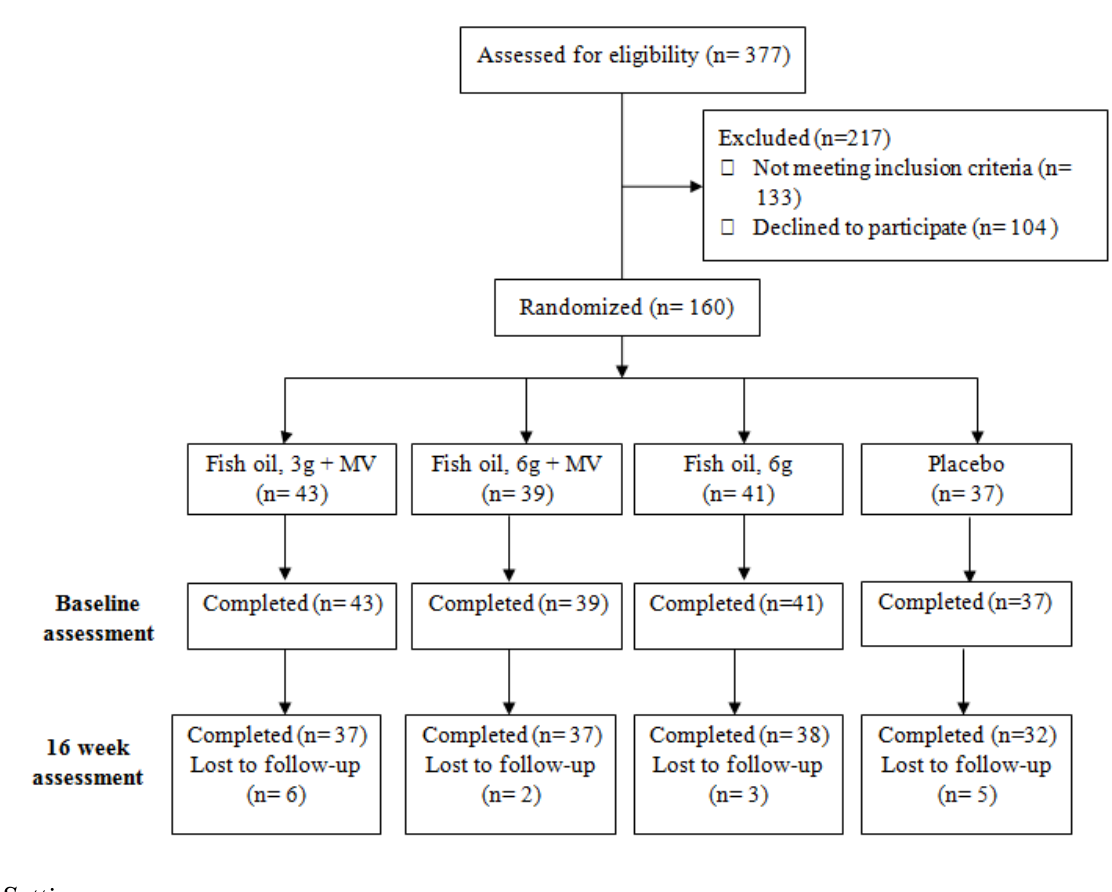
Figure 1. Participant flow diagram. MV: